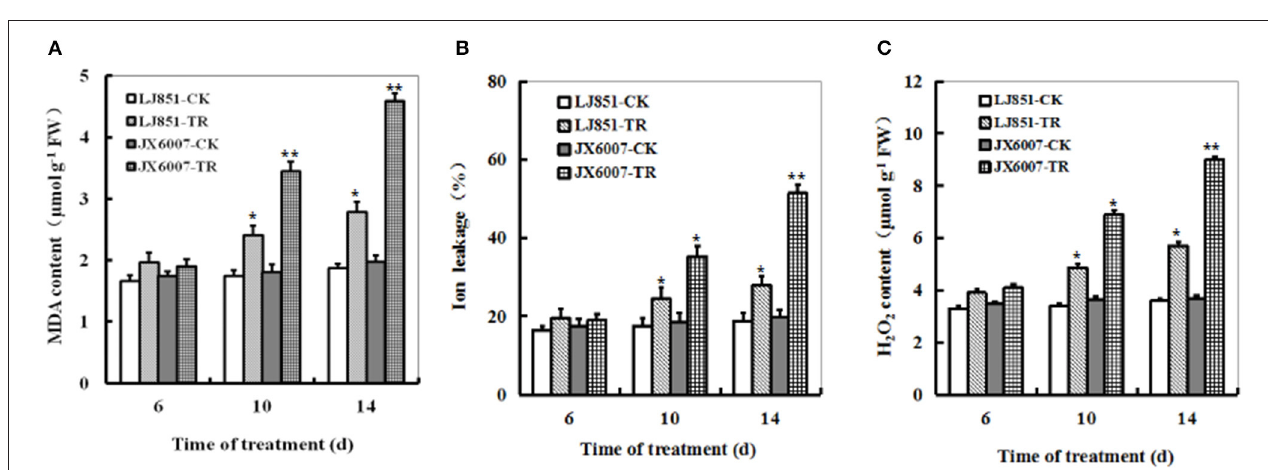
FIGURE 2 | Dynamic changes of MDA content (A), Ion leakage (B) , and H 2 O 2 (C) in both genotypes of flue-cured tobacco plants during 14 days of drought stress. LJ851-CK stands for LJ851 under control conditions; LJ851-TR stands for LJ851 under drought conditions; JX6007-CK stands for JX6007 under control conditions; JX6007-TR stands for JX6007 under drought conditions. Bar indicates SE. * t -test, with P < 0.05; ** t -test, with P < 0.01.